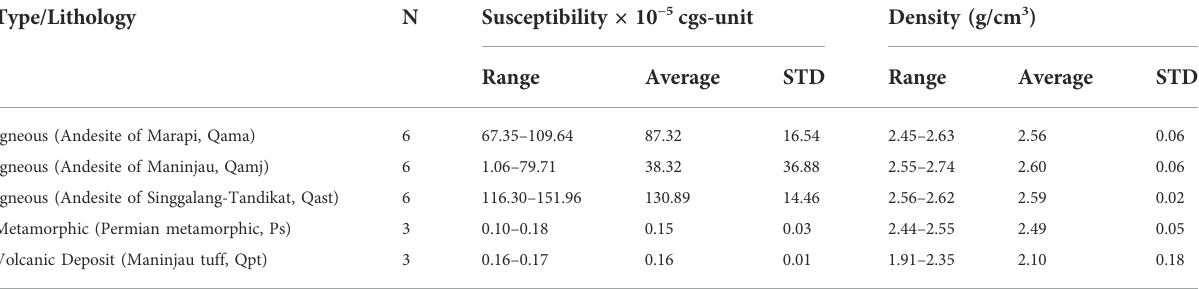
TABLE 1 Magnetic susceptibility and density values of outcrop samples around the Sumani segment. N is number of measured samples while STD is the standard deviation. See Figure 1 for lithological terms.